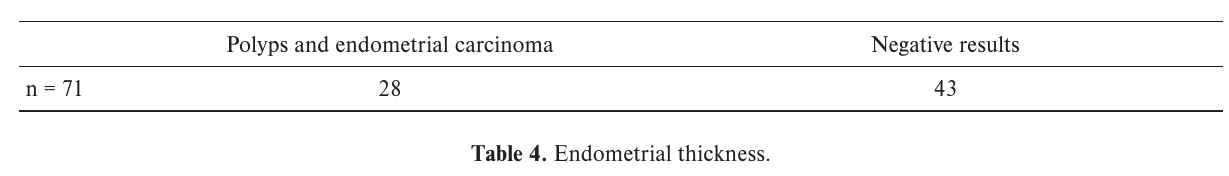
Table 3. Symptomatic patients.